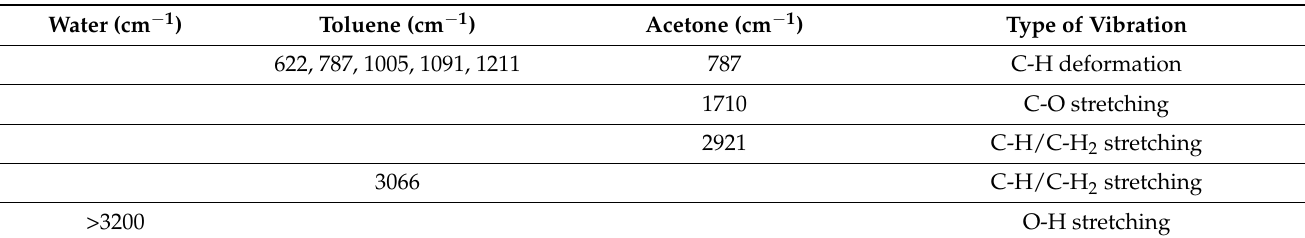
Figure 6. Section of Raman spectra of toluene, acetone and water. Spectral bandwidth of detection fibers are framed with vertical lines (bandwidth of maximum and minimum signal ~300 cm − 1 each). Spectra are offset by 500 and 1000 counts. Table 1. Raman band